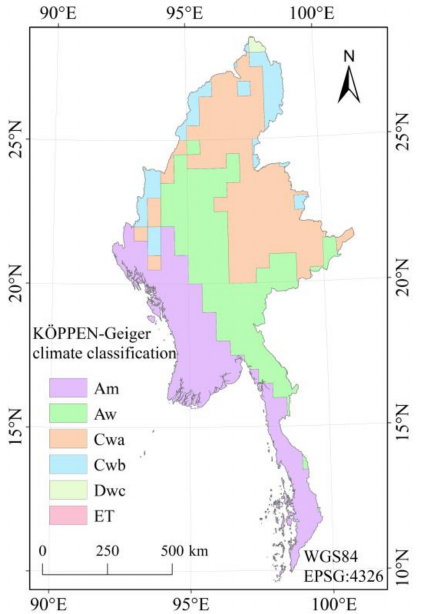
Figure 2. KÖPPEN-Geiger climate zones in